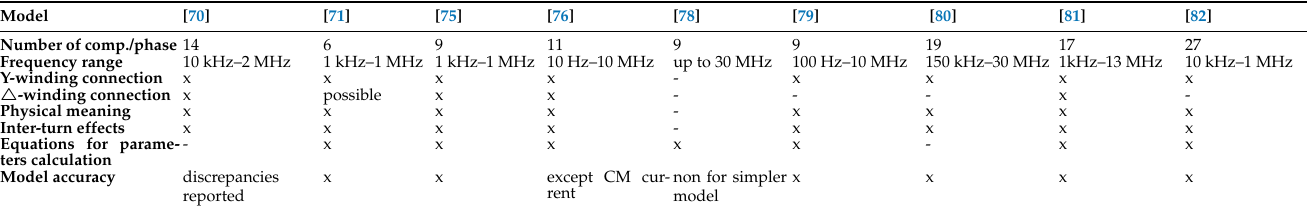
Table 3. HF Motor Model Comparison.